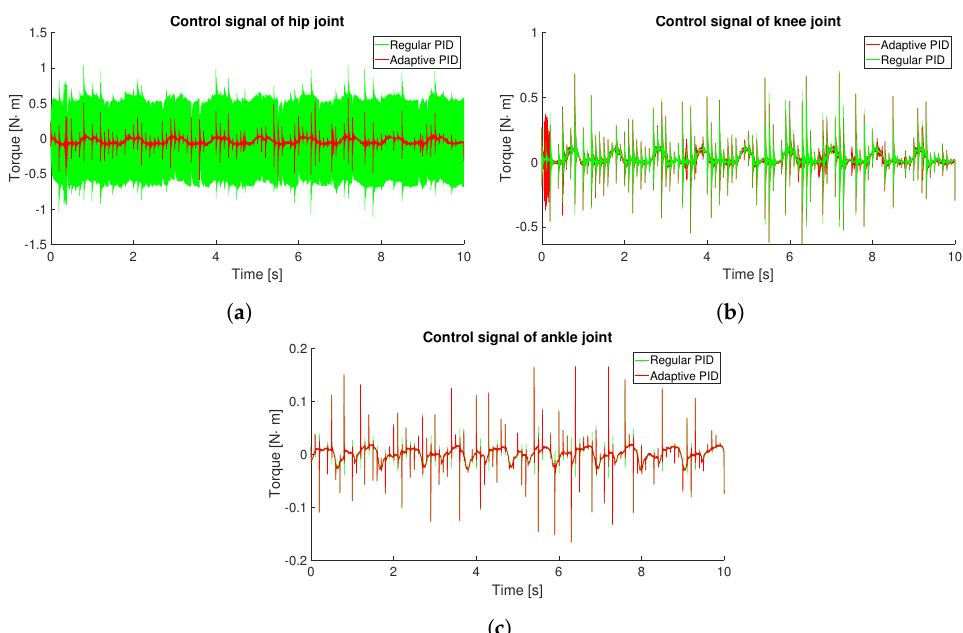
Figure 5. Tracking control signal comparing the proposed adaptive controller (red) scheme with the regular PID controller (green) for the hip ( a ), knee ( b ) and ankle ( c ).